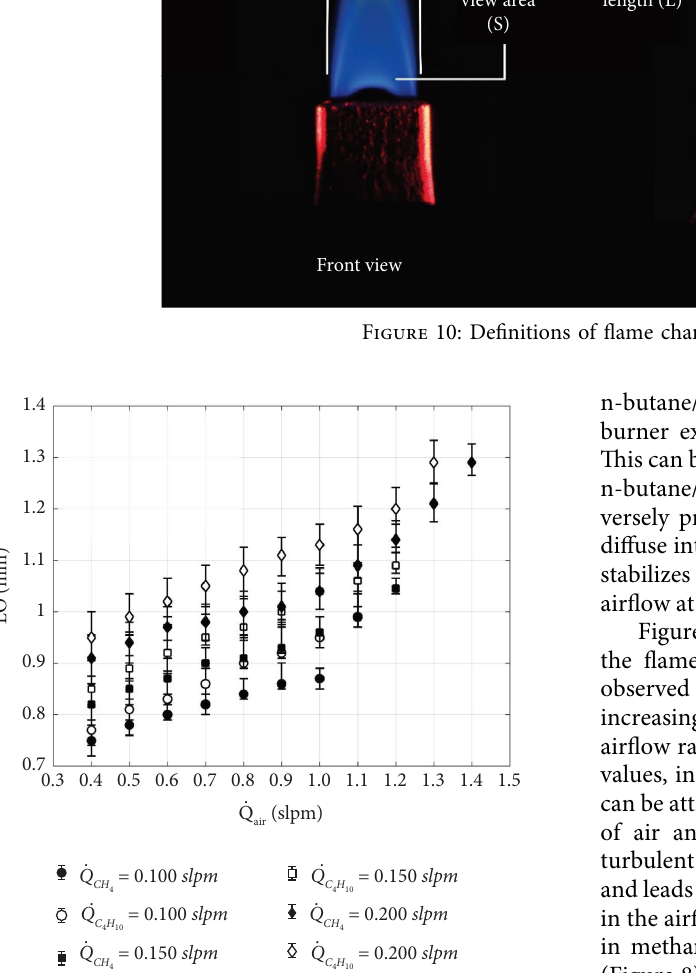
Figure 11: Variation of fame lift-of height with airfow rate for methane and